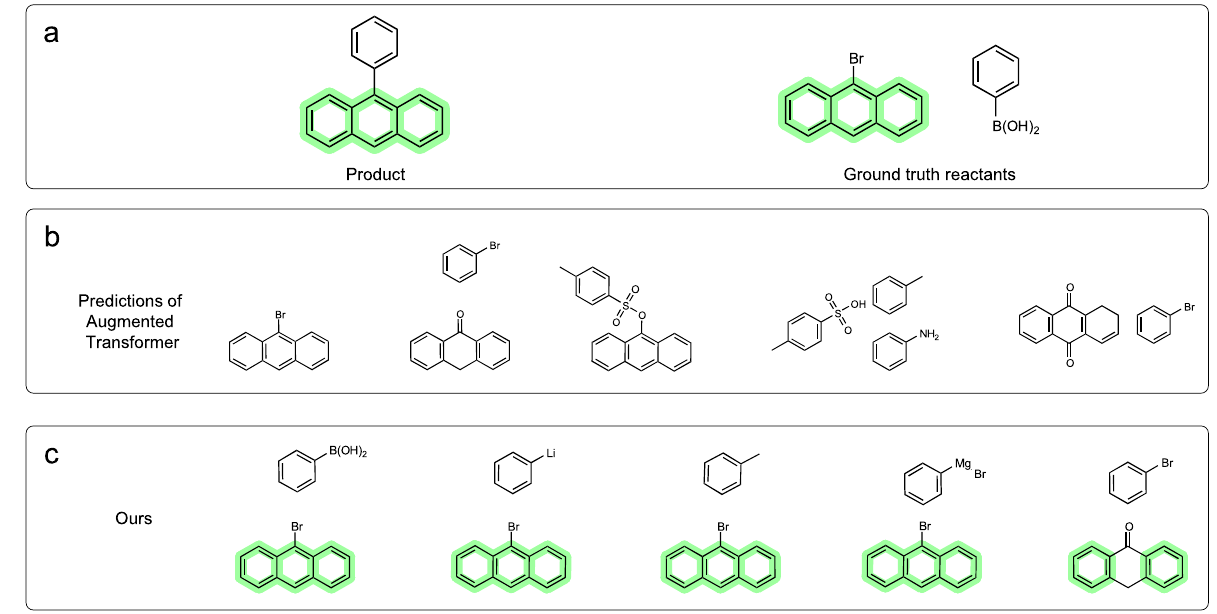
Fig.5|ComparisonwithAugmentedTransformer(substructureshighlighted). a A polycylic aromatic hydrocarbons synthesized with Suzuki – Miyaura coupling reaction. b The predictions from Augmented Transformer 3 ,